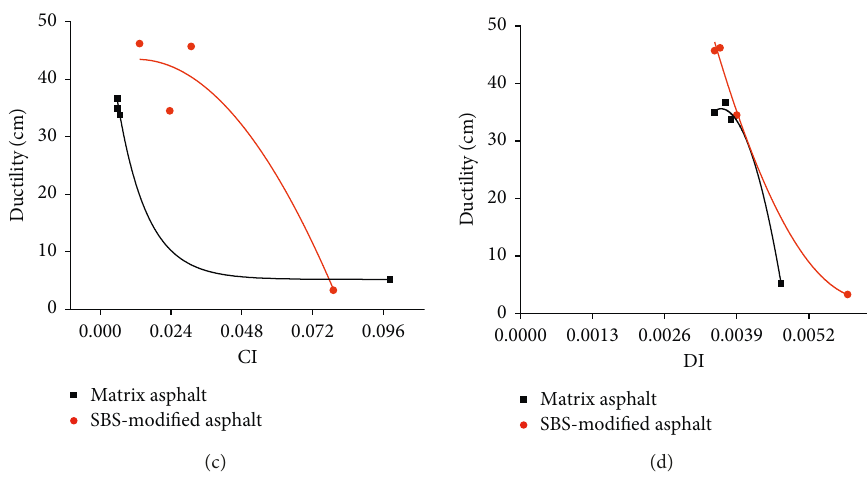
Figure 18: Relationships between the functional group indices and